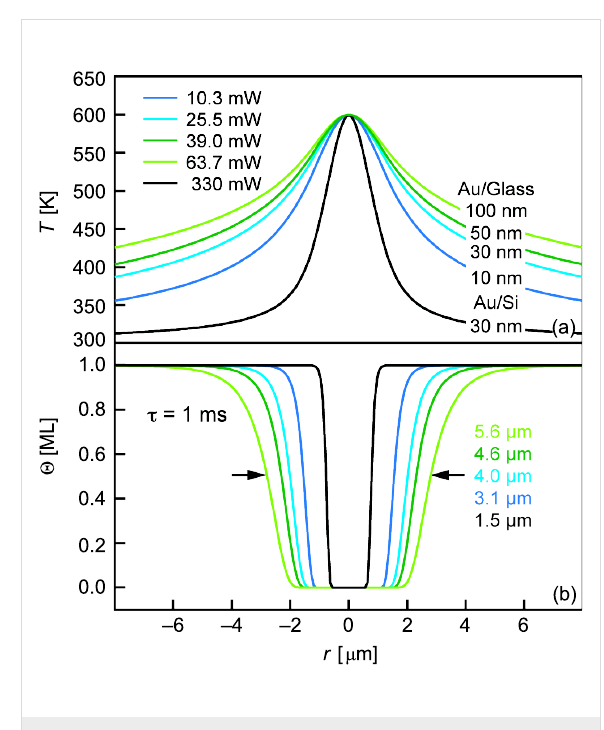
Figure 7: (a) Calculated stationary temperature profiles on different types of Au-coated substrates used for the patterning experiments. Laser powers P were adjusted in order to reach the same peak temperature of 600 K. Values are given in the diagram. (b) Corres- ponding surface coverage profiles at a laser pulse length of τ = 1